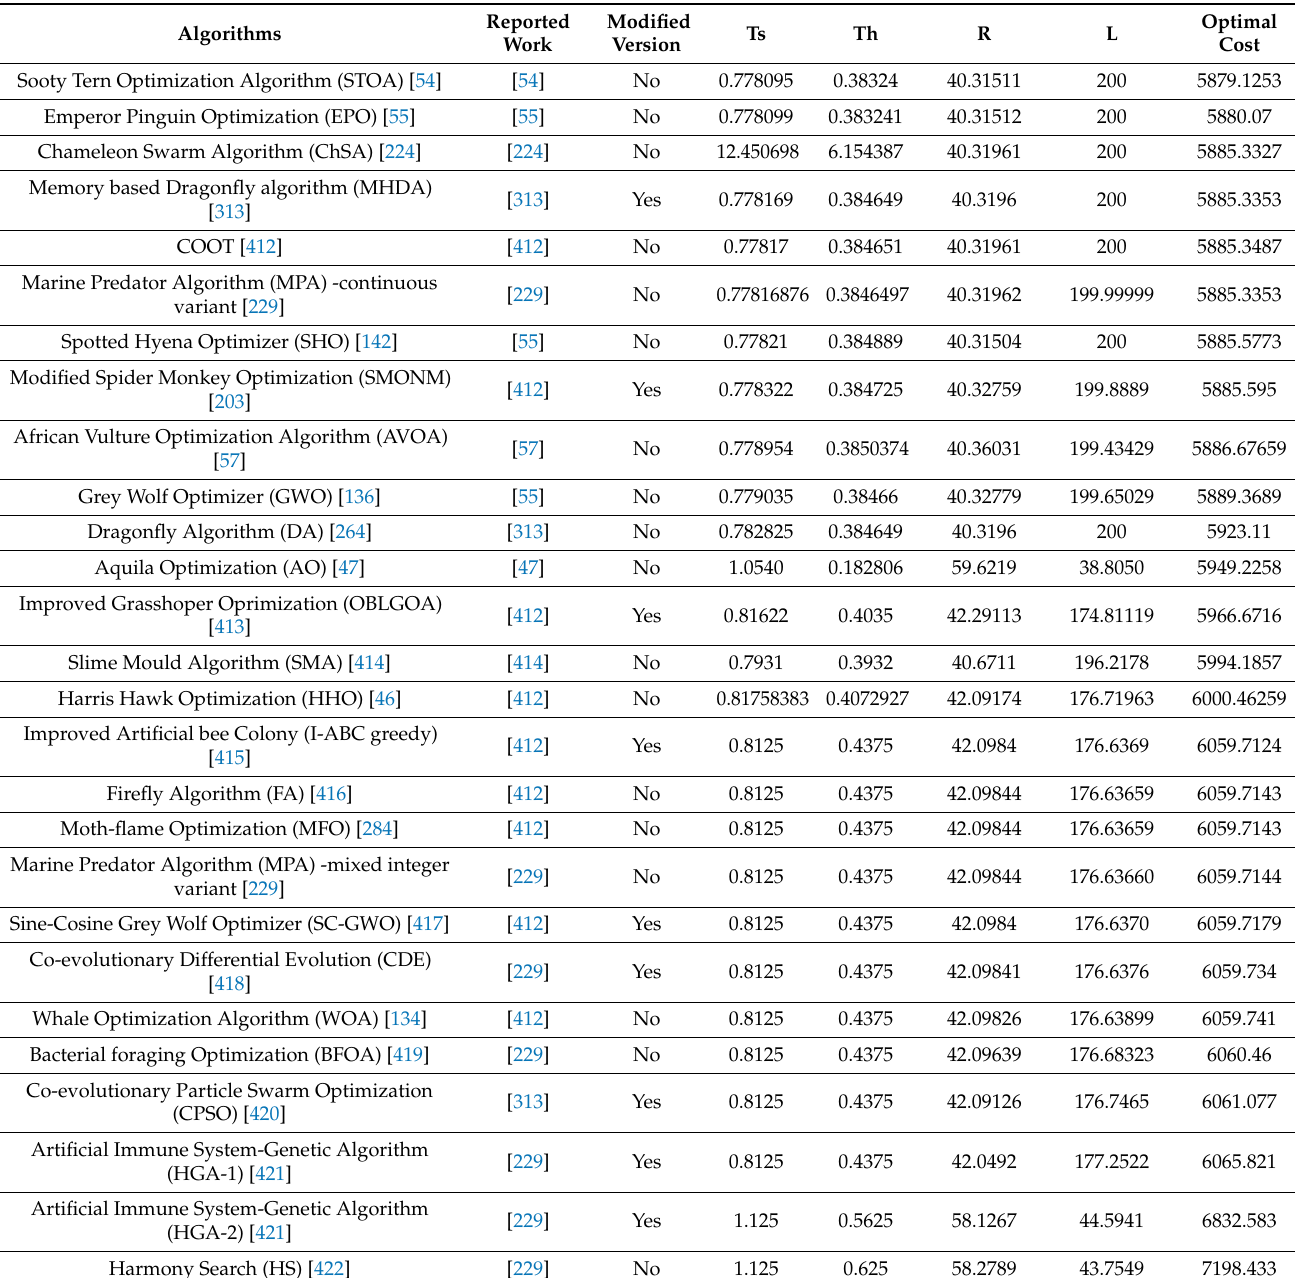
Table 8. Solutions for the pressure vessel design